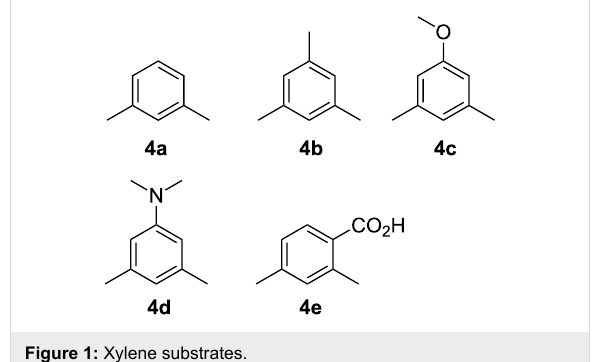
Figure 1: Xylene